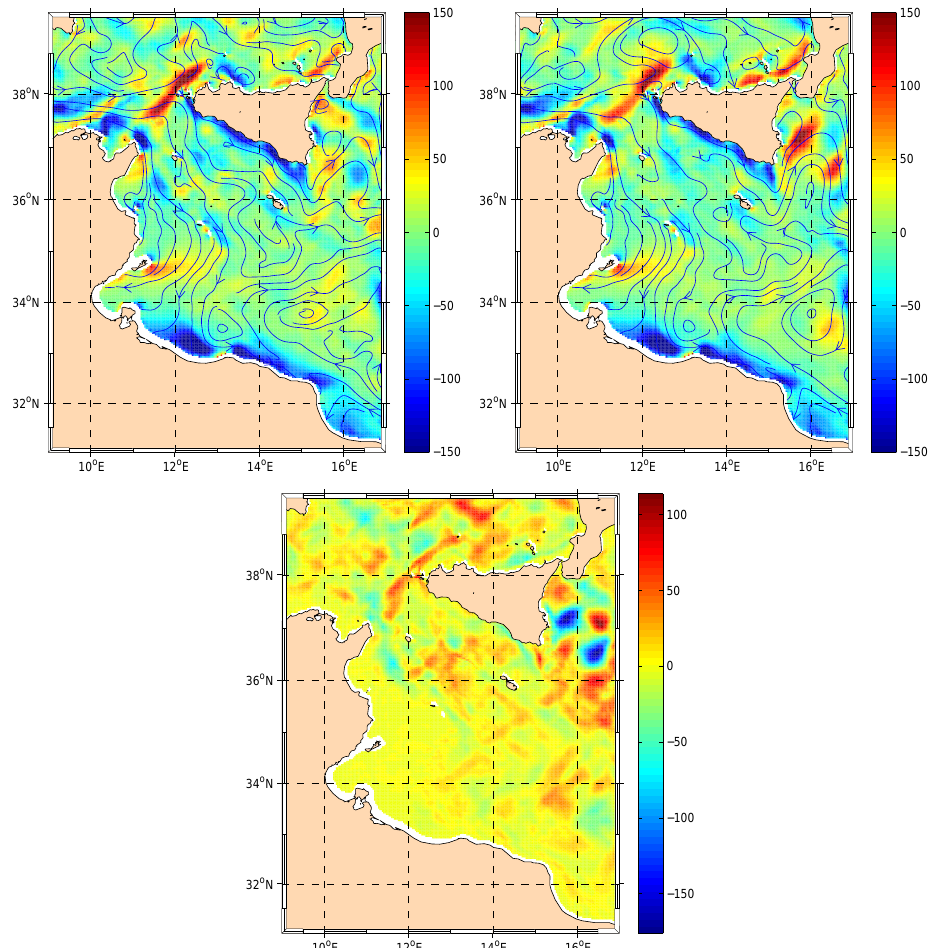
Fig. 7. Reynolds stress covariance <u ′ v ′ > for AN (left) and SIM (right), with streamlines of the mean flow overplotted. Bottom panel shows the difference AN-SIM. Units are cm 2 /s 2 .